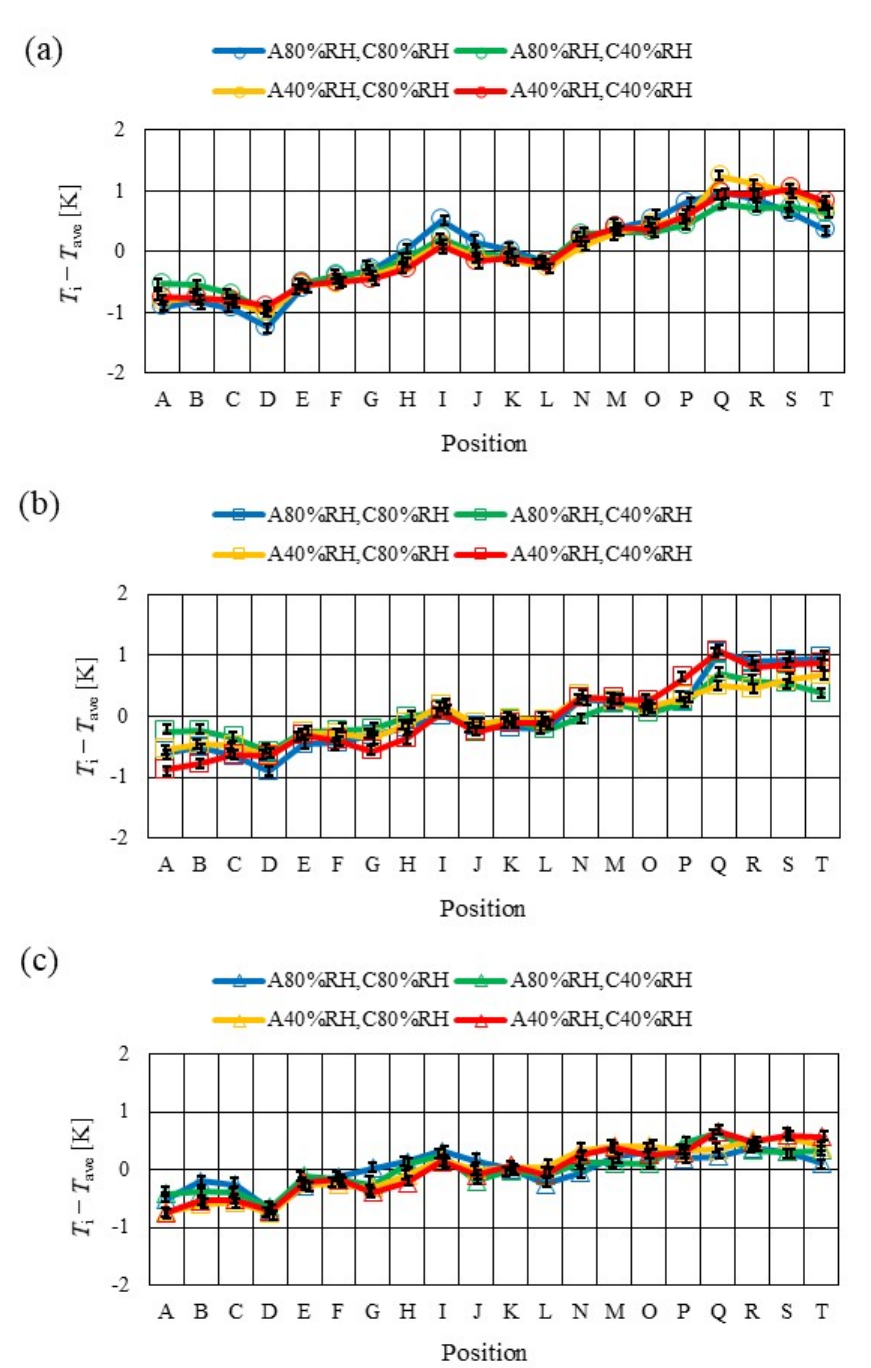
Figure 11. Comparison of the in-plane temperature distribution at the anode side among different RHs in the case of the separator thickness of 1.5 mm: ( a ) T init = 353 K; ( b ) T init = 363 K; ( c ) T init = 373 K.